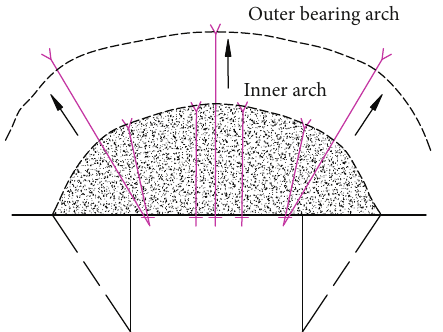
Figure 19: Schematic diagram of the strengthening mechanism of the roof rock layer under the combined support of the anchor cable and anchor rod.